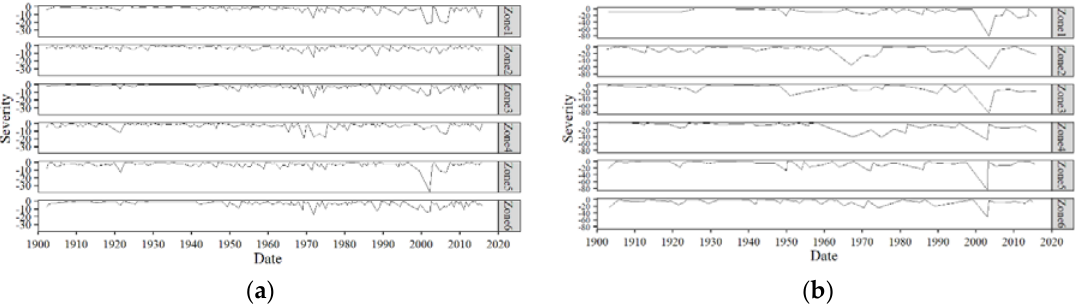
Figure 12. ( a ) 3 ‐ month and ( b ) 12 ‐ month severity of droughts. Figure 12. ( a ) 3-month and ( b ) 12-month severity of droughts. Appl. Sci. 2020 , 10 , x FOR PEER REVIEW